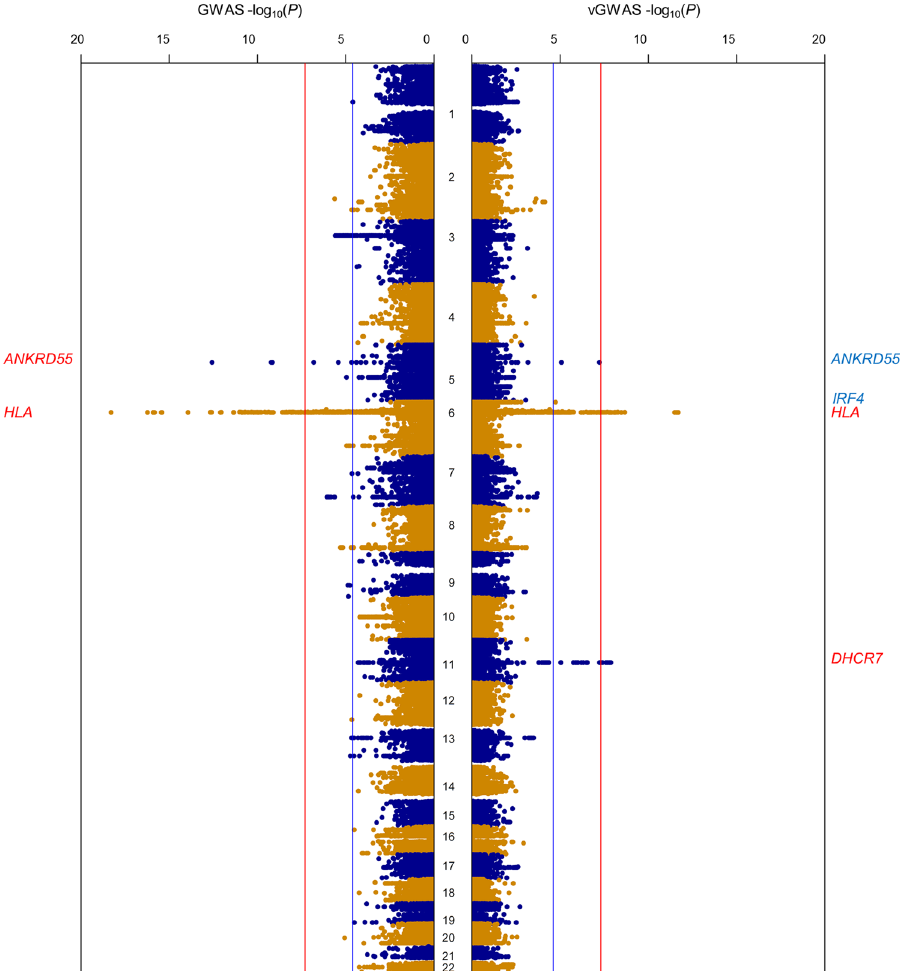
Figure 1. Manhattan plots of GWAS (left) and vGWAS (right) of the combined data in alignment. Each plot uses the -log 10 scale for P values, red and blue lines for genome-wide and Immunochip-wide significance thresholds respectively, and a panel of gene annotations for loci exceeding the Immunochip-wide threshold in blue and the genome-wide threshold in